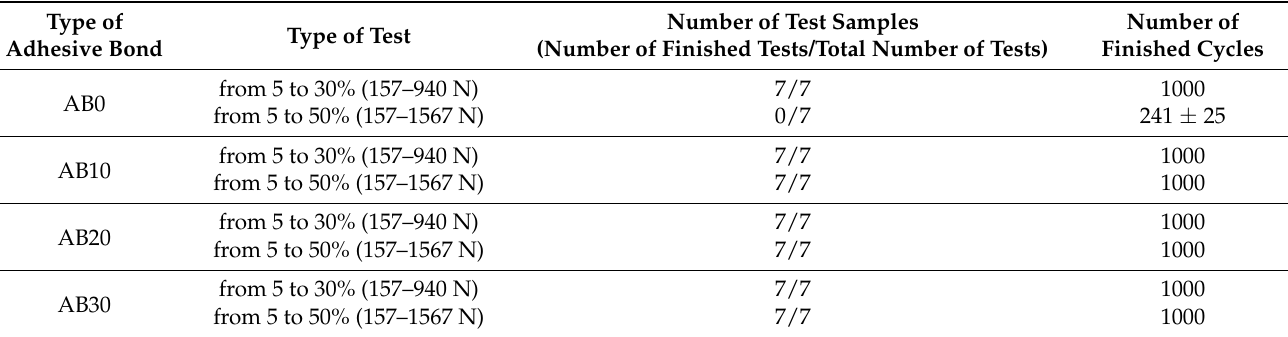
Table 3. Evaluation of cyclic tests of adhesive bonds.